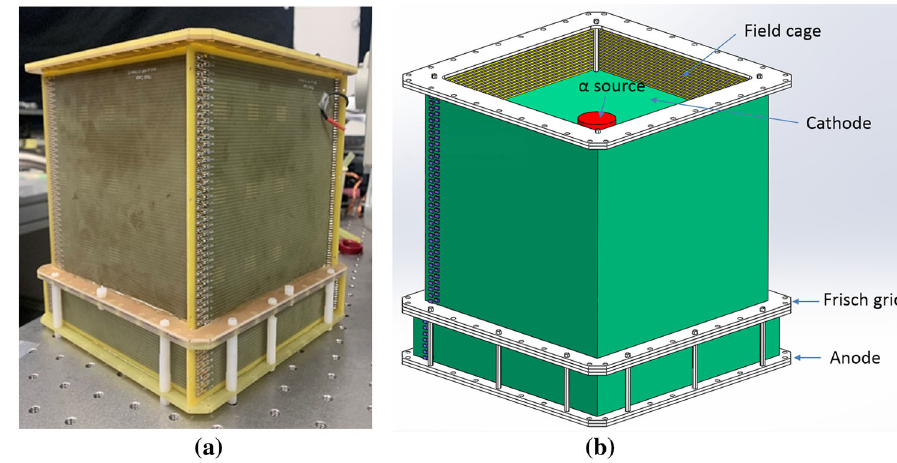
Fig. 1 Schematic drawing ( a ) and photogragh ( b ) of the FGIC used in this work